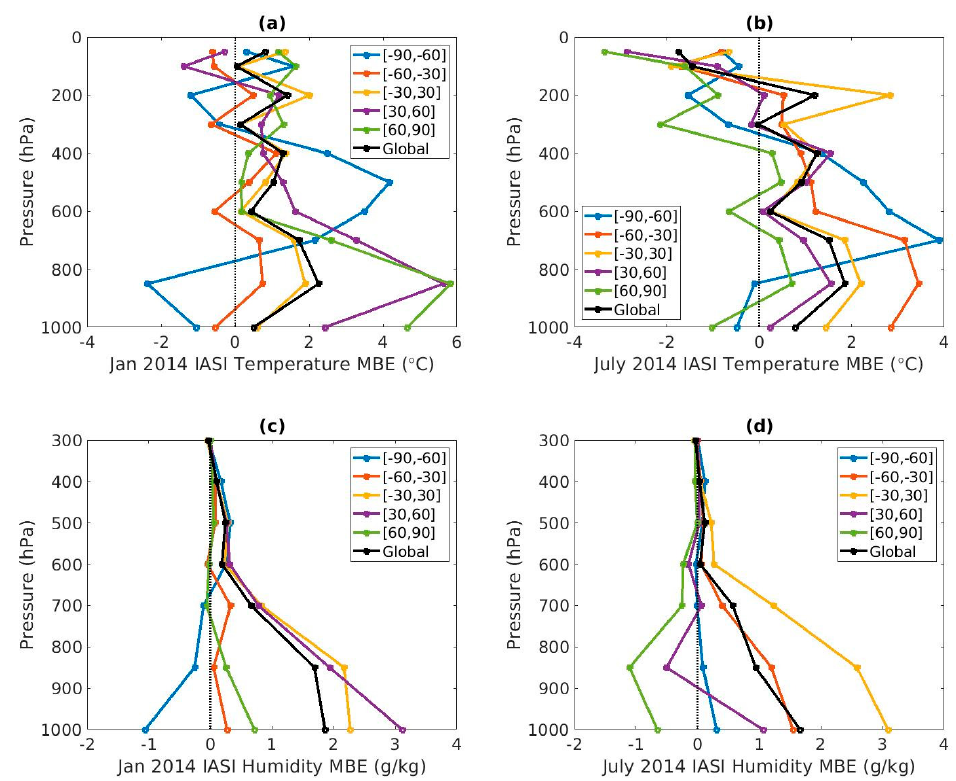
Figure 6. MBE between HIRS and infrared atmospheric sounding interferometer (IASI) retrievals (HIRS-IASI) at standard atmospheric pressure levels, subdivided by latitude ranges. Temperature MBE (°C ) in ( a ) January 2014; and ( b ) July 2014. Humidity MBE (g/kg) in ( c ) January 2014; and ( d ) July 2014.